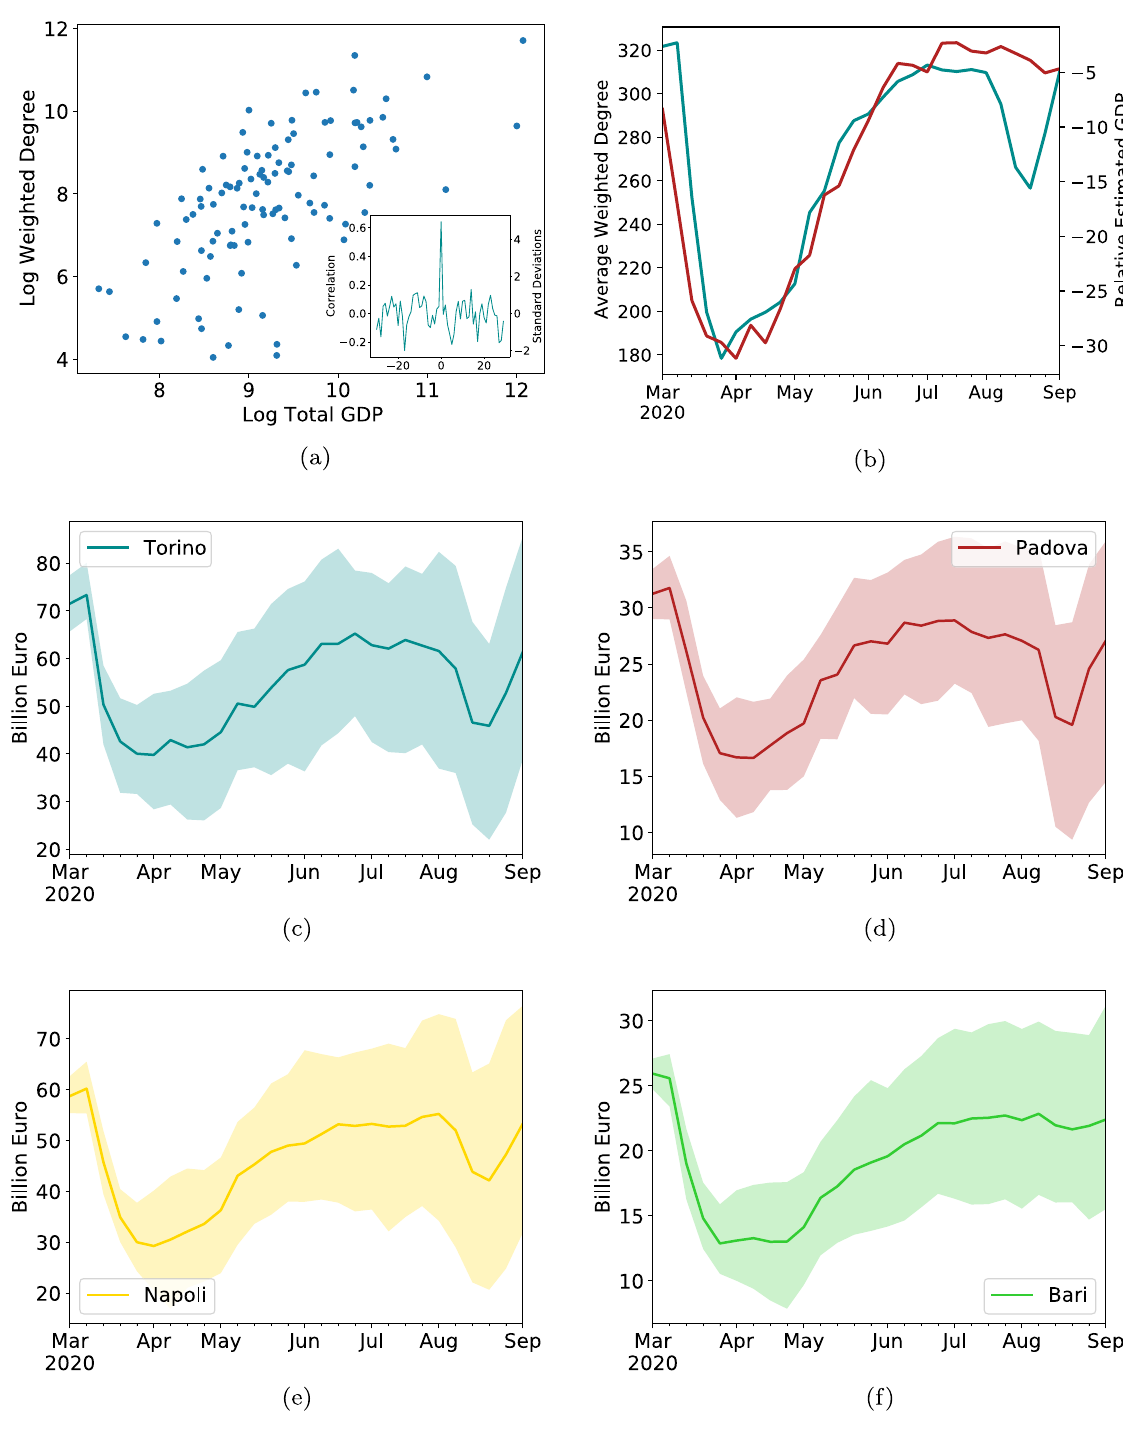
Figure 7. Inferring the economy from mobility. ( a ) The correlation between the GDP levels of individual Provinces for 2017 and the weighted Province degree. Log of values is shown to highlight the relation holds regardless the strongest Province economies. Inset-shifted correlation to validate the significance of the relationship ( b ) The Average weighted degree, teal, left axis; and the EGDP estimates, red, right axis. Here, as in the right panel of Fig. 1 we see the similarity in dynamics. ( c )–( f ) The Province-based GDP forecast based on mobility data for Turin, Padua, Como and Pisa Provinces. The thick line is the average forecast, with the shaded area showing the 25–75 percentile